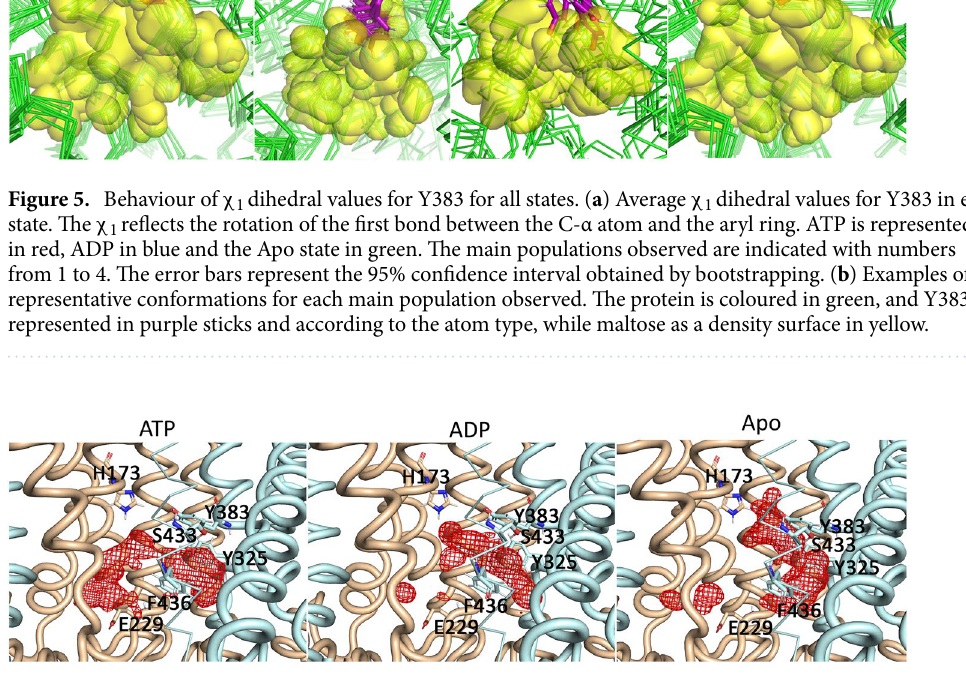
Figure 6. Maltose binding in the transmembrane domains. The isosurface was build using the center-of-mass positions of maltose. MalG is represented in beige, while MalF in light blue. Key residues that interact with maltose are represented in sticks. The red mesh represents the distribution of the maltose